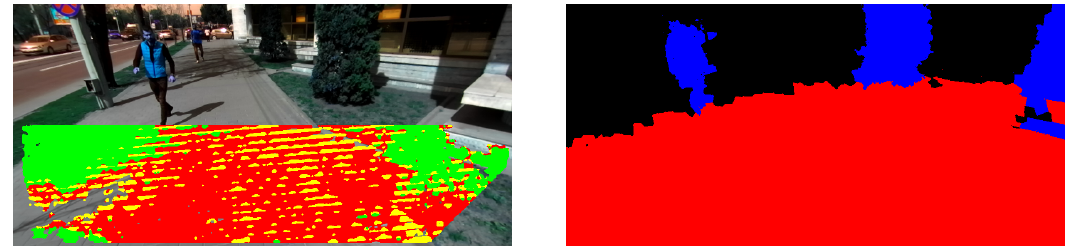
Figure 5. Example segmentation result. ( Left ) Initial ground surface detected using the approach based on the row histogram of the disparity map. Points marked with red fit the estimated ground plane within a 15 cm threshold. Points in yellow fit this plane within 20 cm error and the ones in green are below this plane at more than 20 cm. ( Right ) Labeled superpixels as a result of ground refinement and obstacle